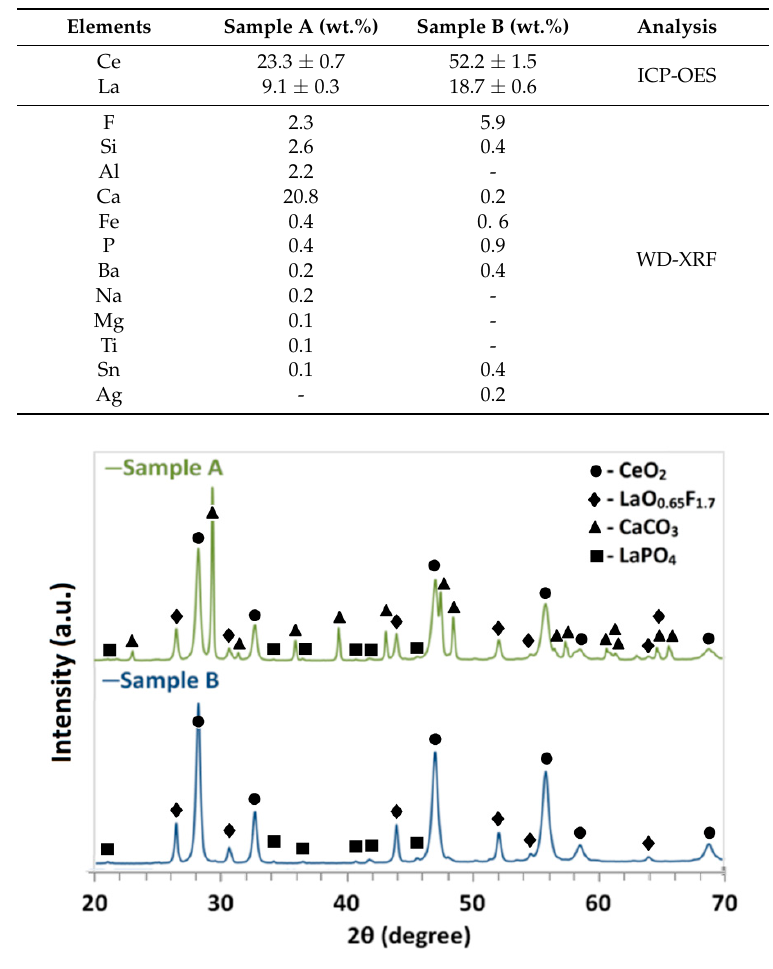
Figure 1. X-ray diffraction (XRD) patterns of polishing waste samples. Sample A is from plate glass polishing and sample B is from mirror polishing.